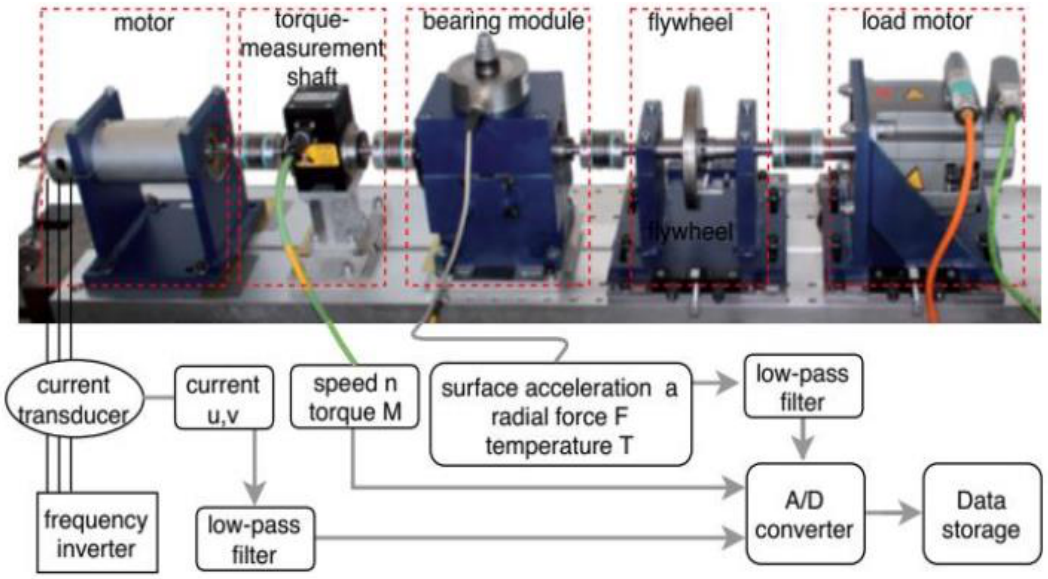
Figure 5. The test rig of the KAT-bearing data center.